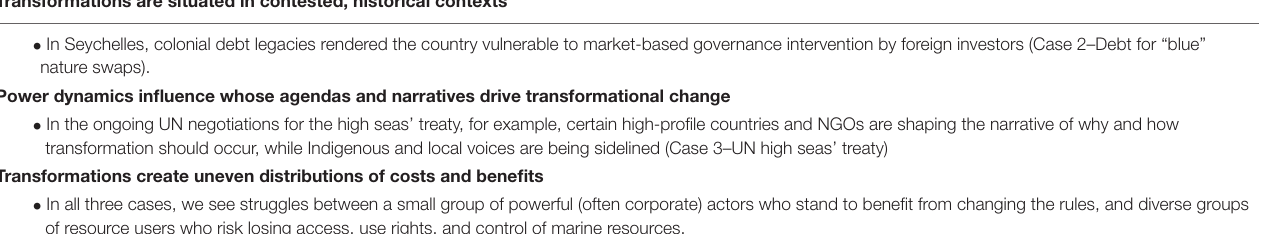
TABLE 1 | Examples of the political nature of ocean governance transformations derived from the three case studies reviewed in this paper. Transformations are situated in contested, historical